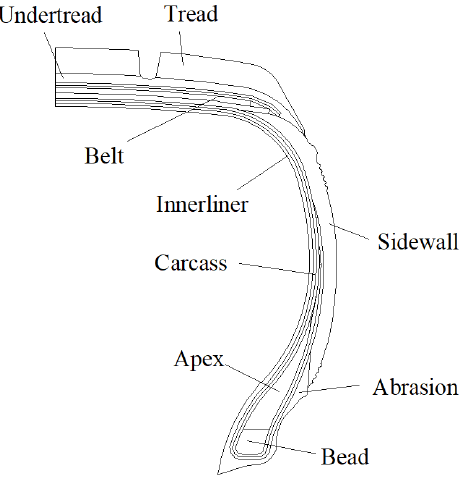
Figure 1. Material distribution of a 175/75R14 tire.